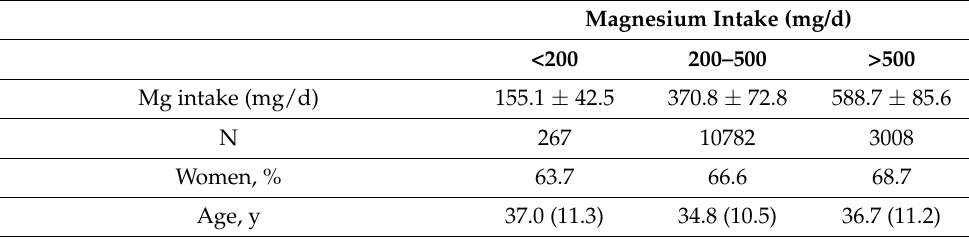
Table 2. Baseline characteristics of participants according to three categories of magnesium intake among participants in the SUN (“Seguimiento Universidad de Navarra”) cohort, 1999–2016 a